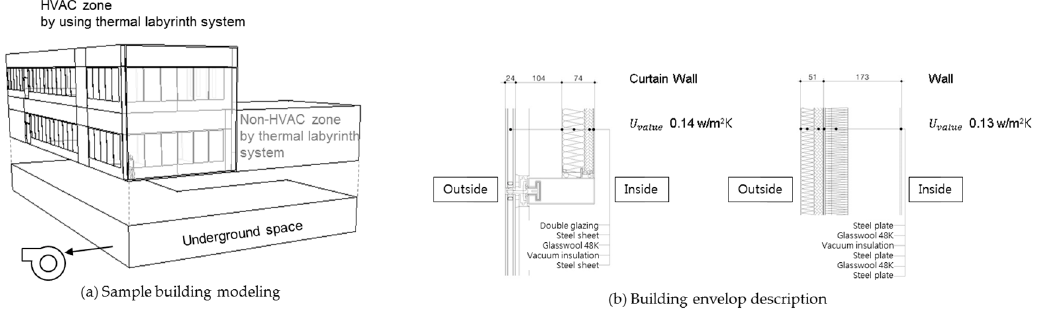
Figure 12. Sample building modeling and building envelop description.